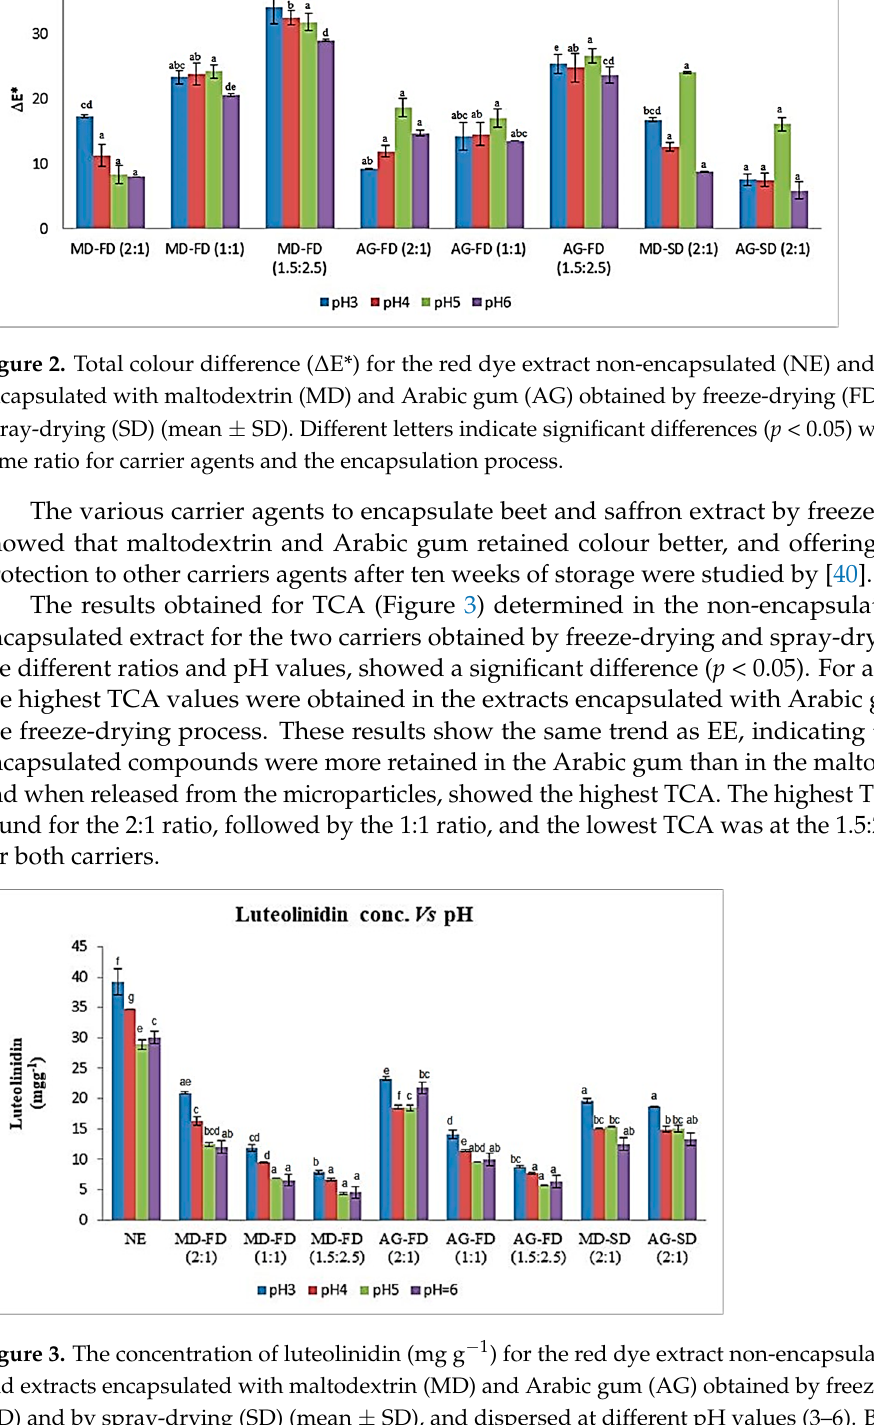
Figure 1. Chemical structures and molecular weights of 3-DXA and derivatives present in red sorghum. Nomenclature and two characteristics fragment ions of anthocyanins are also illustrated in the figure.